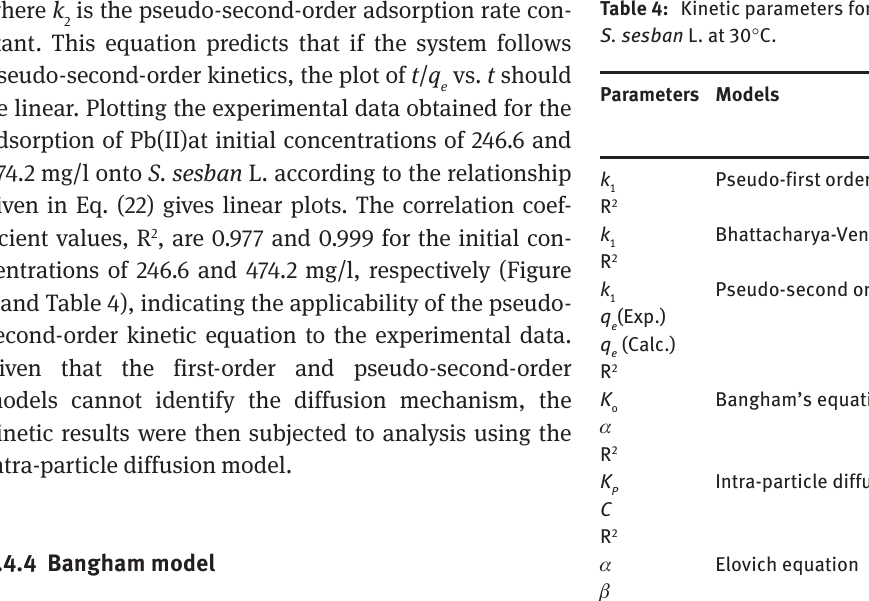
Table 4: Kinetic parameters for the adsorption of Pb(II)